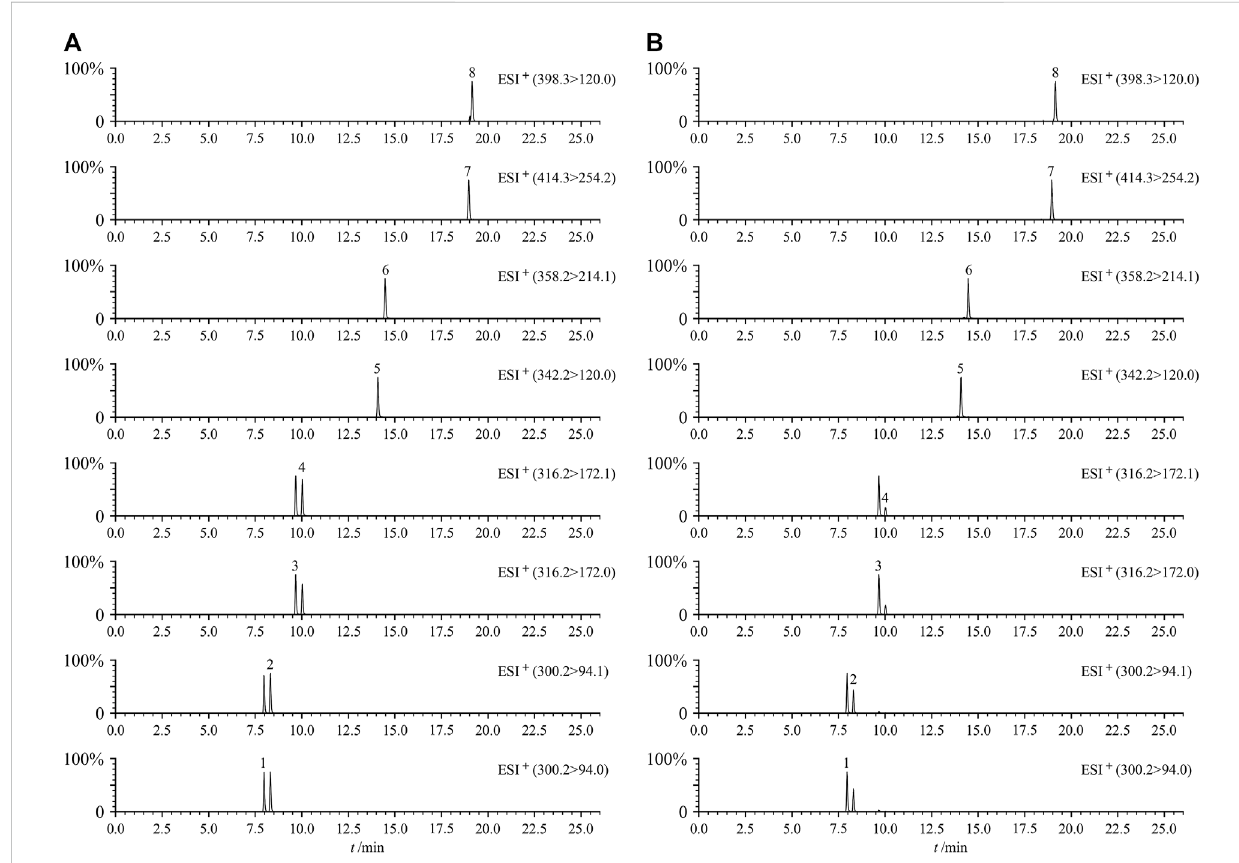
TABLE 3 Calibration curves, LLOD and LLOQ of the 8 PAs.